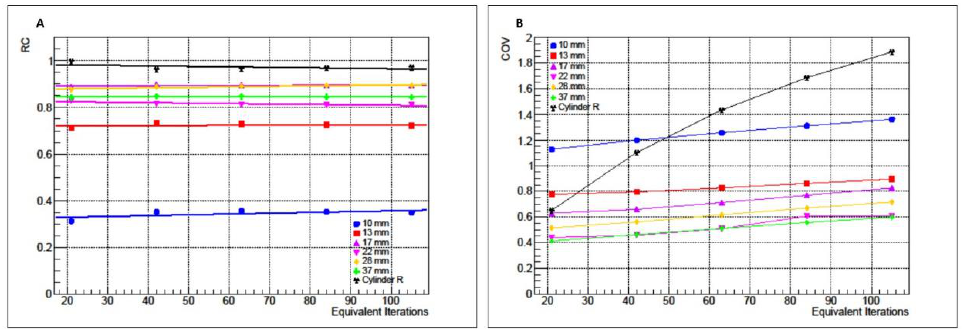
Figure 2. RC ( A ) and CoV ( B ) values for cylindrical phantom (black) and IEC NEMA Body phantom as functions of EI.